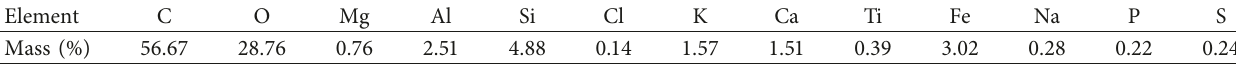
Table 3: Chemical composition of DNL.